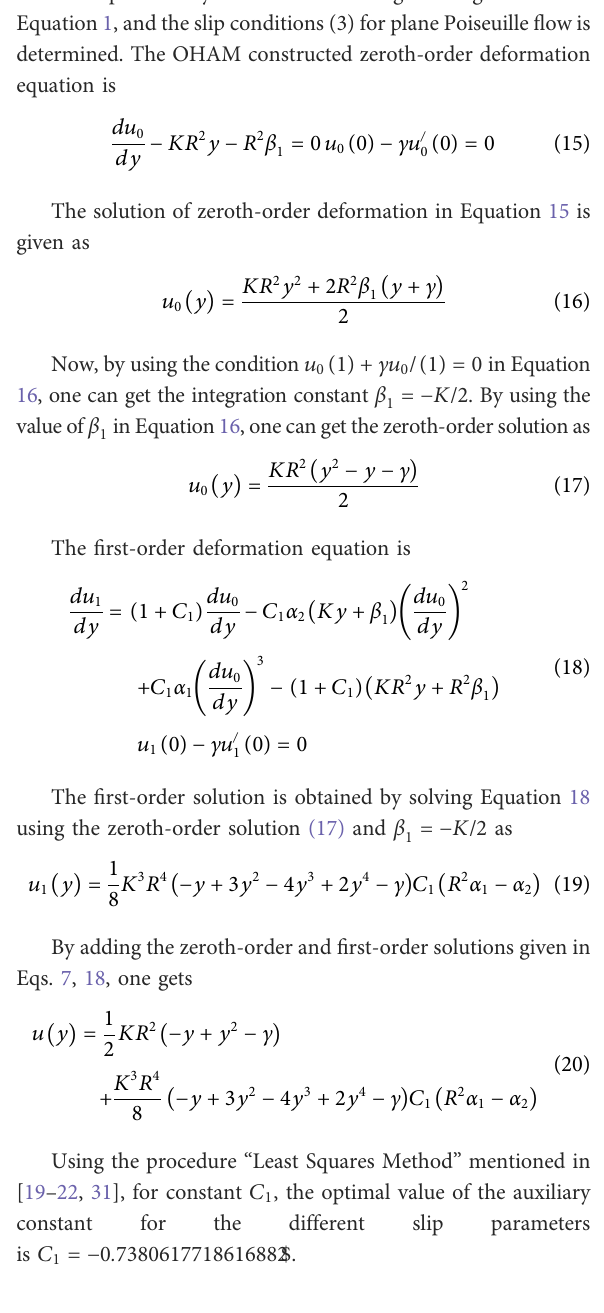
TABLE 1 Optimal values of auxiliary constant C parameters (plane Couette fl ow).